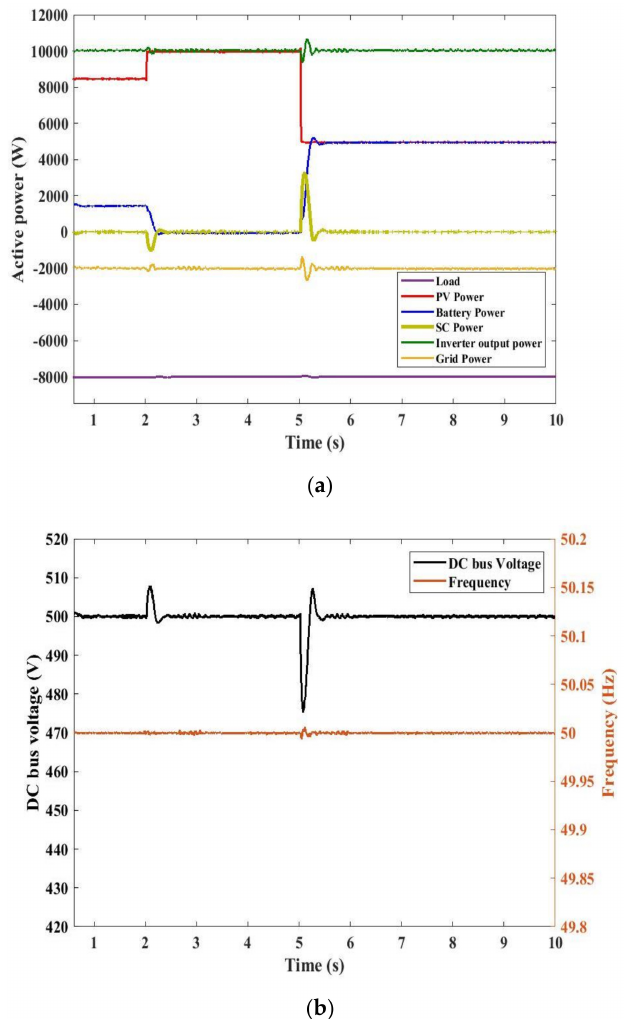
Figure 15. For PV Power Variation; ( a ). Different Source active power variations ( b ) Frequency and DC bus